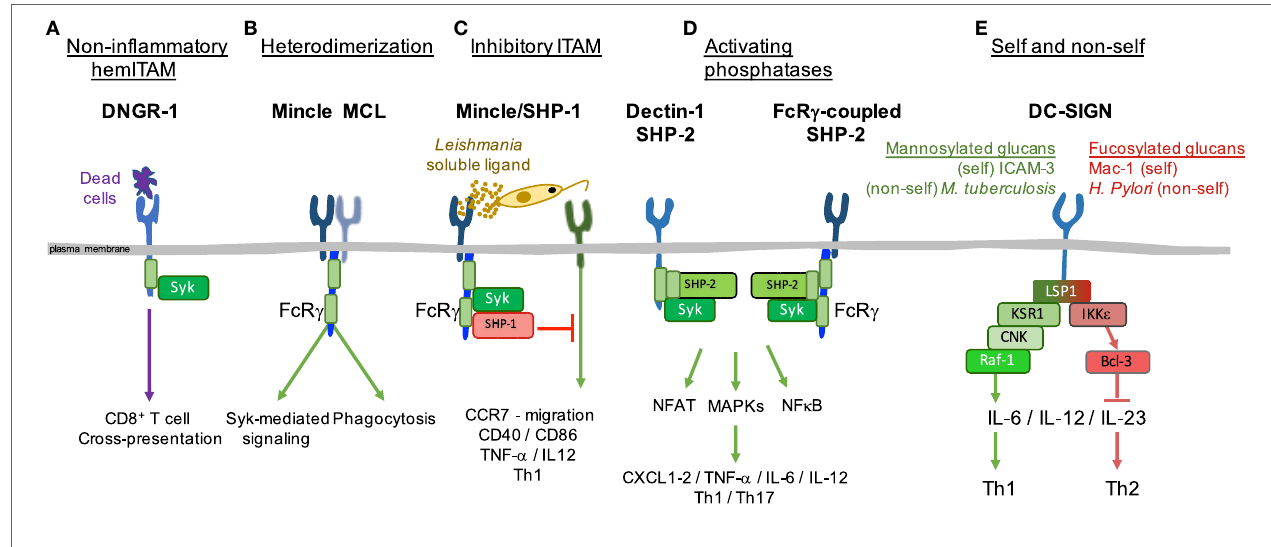
FiGURe 2 | Signaling flexibility downstream of C-type lectin receptors (CLRs). Signaling triggered downstream of CLRs goes beyond the canonical modules present in their intracellular domains and can be modulated by different processes. Some examples of such plasticity are represented. (A) DNGR-1 promotes cross-presentation of antigens to CD8 + T cells, yet not directly contributing to inflammation. (b) Mincle and MCL dimerize, boosting phagocytosis, and spleen tyrosine kinase (Syk)-mediated inflammatory responses. (C) Sensing of a soluble ligand from Leishmania by Mincle triggers an inhibitory immunoreceptor tyrosine- based activating motif conformation downstream of Fc receptor γ (FcR γ ), where SHP-1 dampens inflammatory responses triggered by heterologous receptors. (D) The phosphatase SHP-2 acts as a scaffold downstream of Dectin-1 and FcR γ -coupled CLRs, facilitating the recruitment of Syk and its inflammatory signaling. (e) Both self and non-self ligands share signaling pathways downstream of DC-SIGN depending on whether they are mannosylated or fucosylated